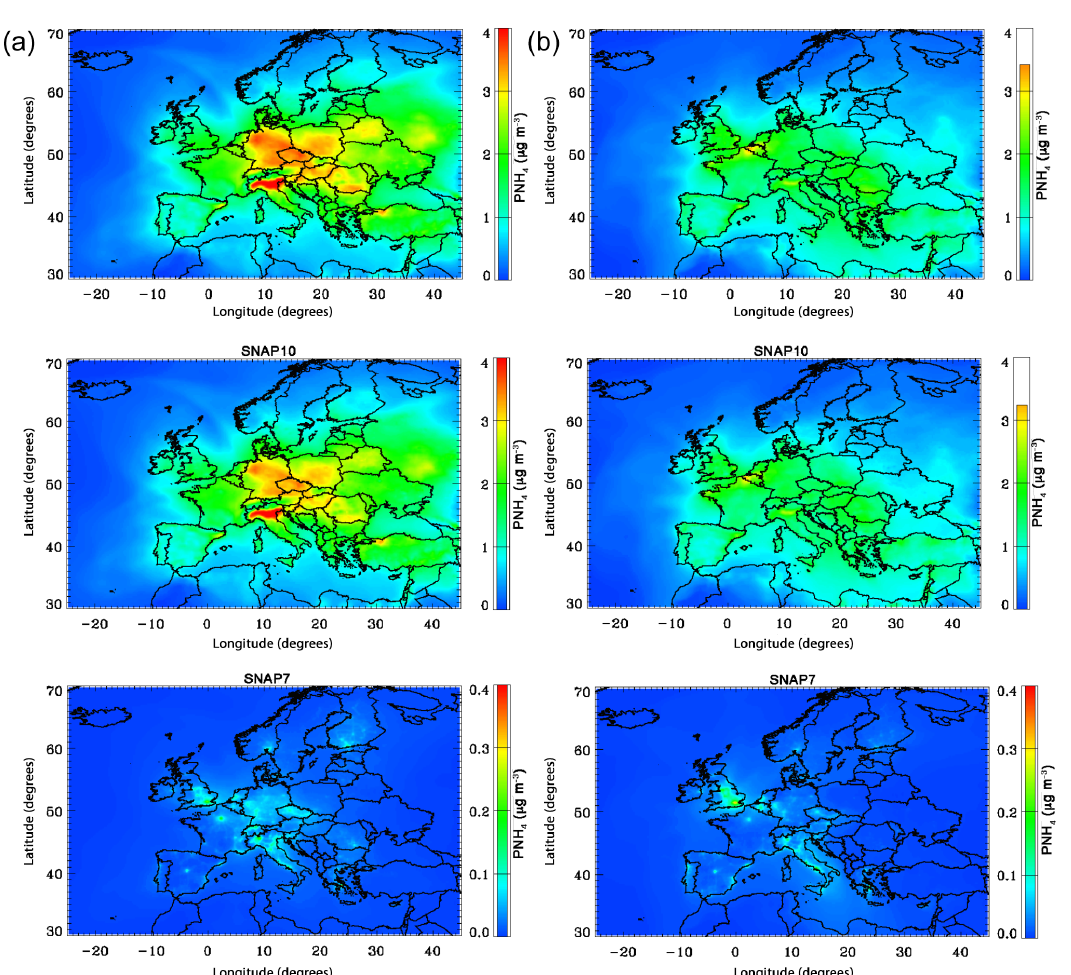
Figure 4. Average concentrations of PNH 4 (top panels) and contributions from agriculture (SNAP10) and road transport (SNAP7) in February–March 2009 (a) and in June 2006 (b) .